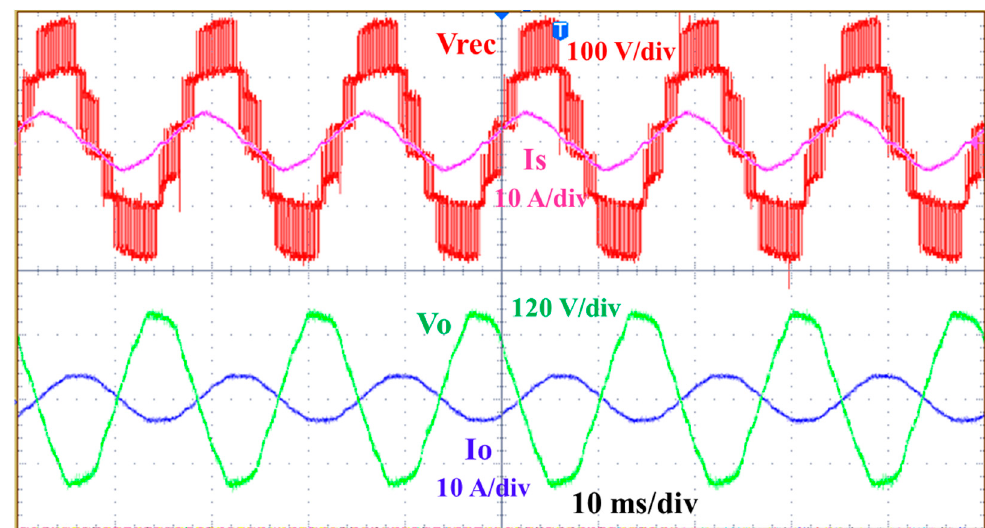
Figure 16. Experimental result for input and output waveforms with regenerative operation.